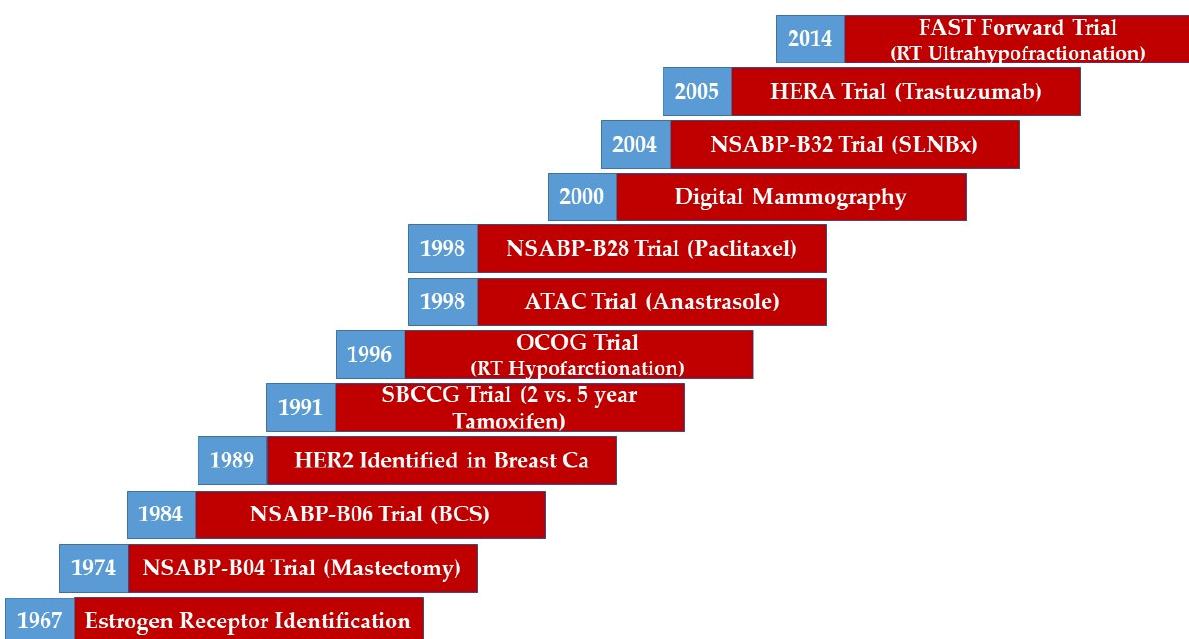
Figure 1. A timeline illustrating the evolution of breast management. Abbreviations: BCS, Breast Conserving Surgery; CA, Cancer; HER2, Human Epidermal Growth Factor 2; RT, Radiotherapy. Note: This figure represents a broad overview of the evolution of breast management. However, it does not represent the exact time of the adoption of the measure in the trial. Trials are reported by end accrual dates.